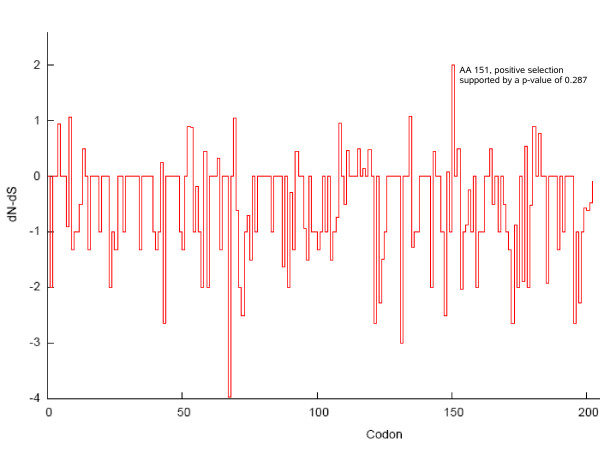
Sliding window representing the rate of synonymous and nonsynonymus nucleotide substitutions per site from serotype A sequences. The extent of positive and negative selection on individual codons. The value above and below the abscissa, indicates the number of per-site nonsynonymus substitutions (dN) over per-site synonymous ones (dS) in an individual codon. The zero value means dN = dS. Site 151 shows evidence for significant positive selection (P < 0.05) based on the extended binomial distribution.